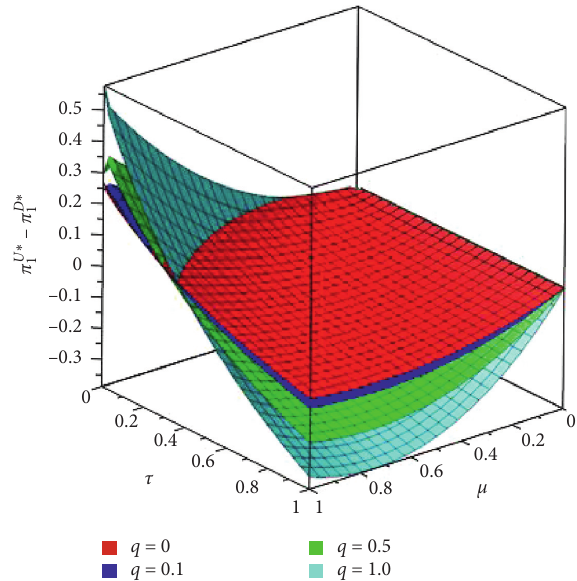
Figure 9: The changes of ( Δ π � π U ∗